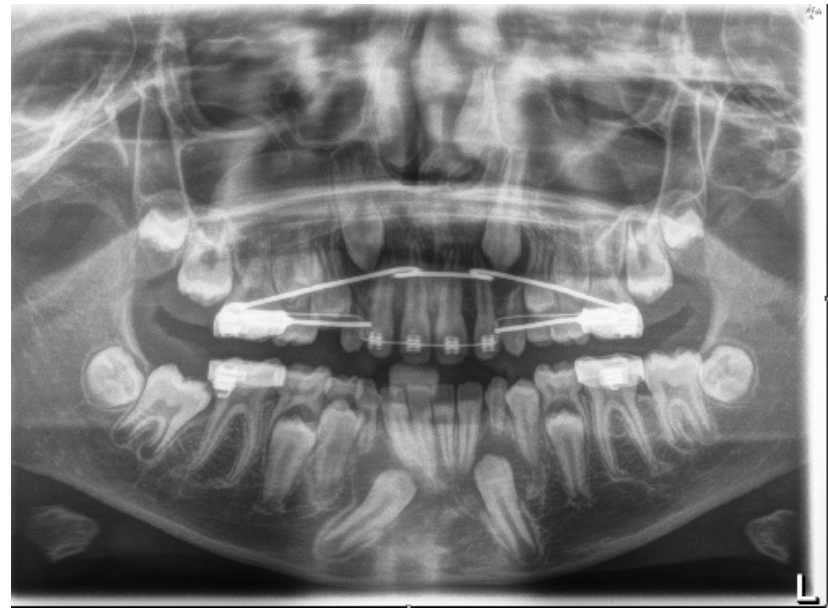
Figure 8. Rx OPT with inclusion of element 4.3.